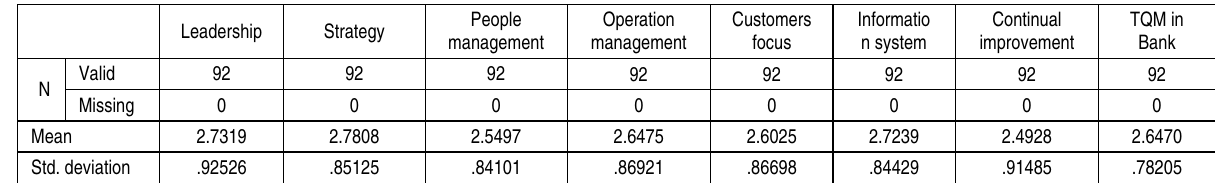
Table 1. Descriptive statistics